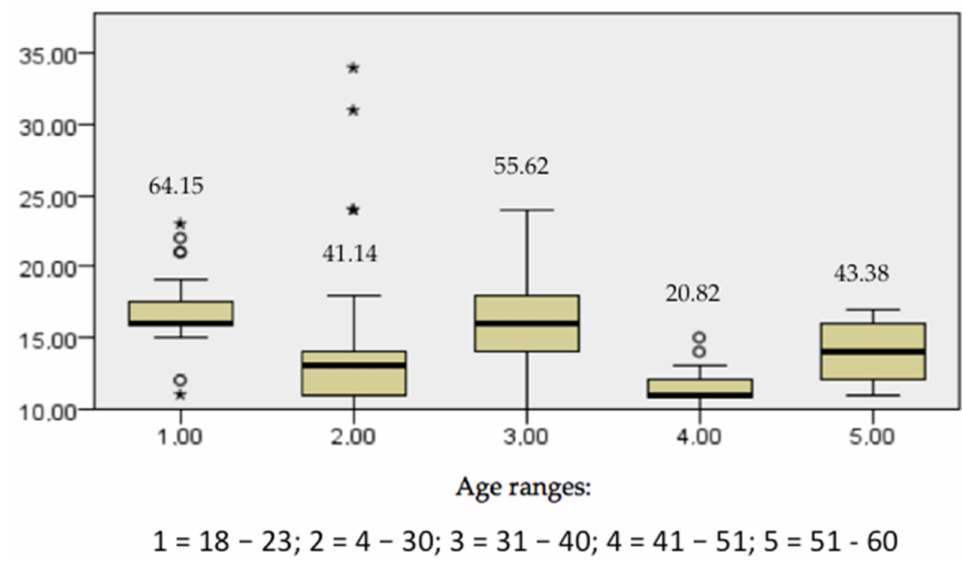
Figure A3. Average ranges of the Psychological Distress in Non-Formal Contexts scale as a function of the variable basketball qualifications. * Values more than 3 interquartile ranges, ◦ Values more than 1.5 but less than 3 interquartile ranges.